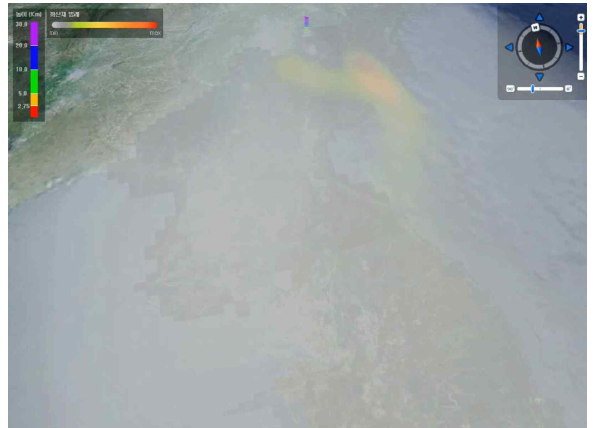
Figure 12. 3D visualization result with "Semi-transparent Volcanic Ash Plane"